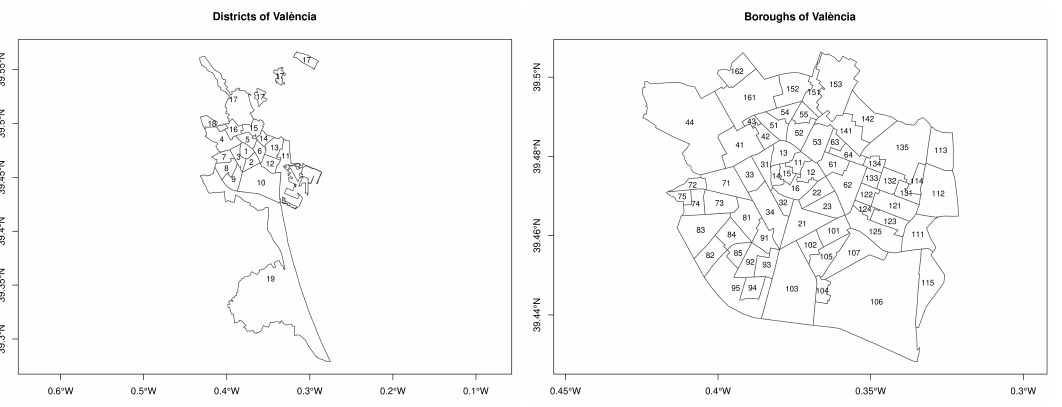
Figure 1. Districts ( left ) and boroughs ( right ) of